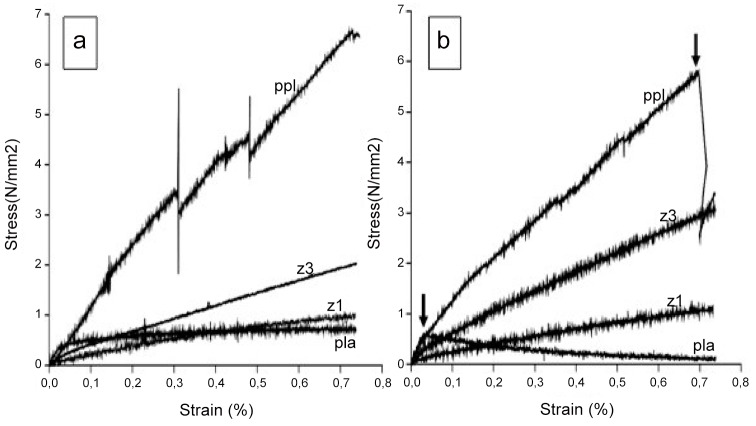
Stress vs strain plots of the 4 different materials.Ramp uniaxial tensile test before (A) and after (B) 7 days under dynamic distention in an EBERS bioreactor.